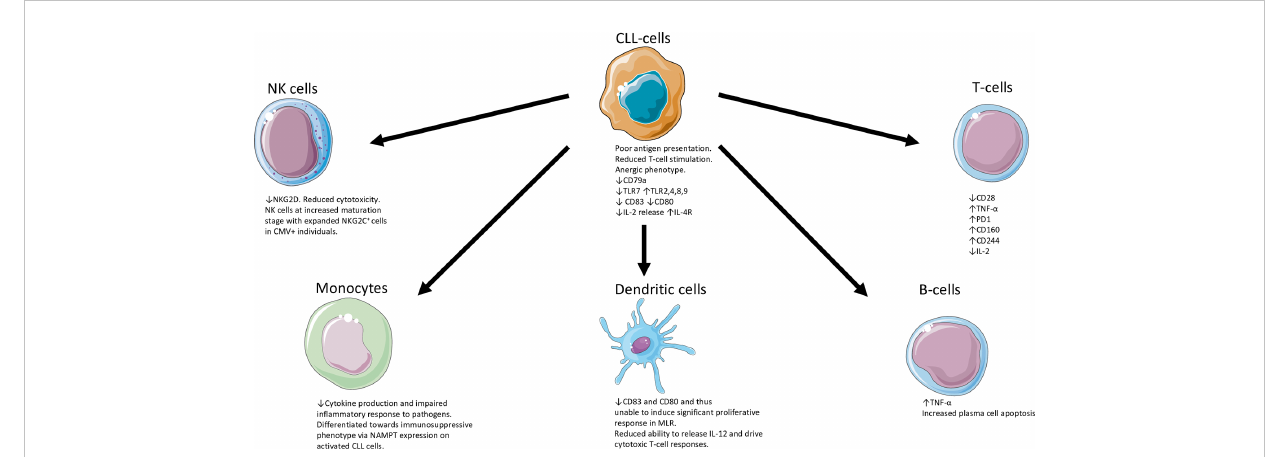
FIGURE 1 Overview of the disruption and chaos of the immune system in patients with CLL (5, 15 – 29). CLL, chronic lymphocytic leukaemia; IL-2, interleukin 2; IL-4R, interleukin-4 receptor; NK, natural killer; TLR, Toll-like receptor; MLR, mixed lymphocyte reaction; NAMPT, nicotinamide phosphoribosyltransferase; PD1, Programmed death protein 1; TNF, Tumour necrosis factor; TLR, Toll receptor. The Figure was partly generated using Servier Medical Art, provided by Servier, licensed under a Creative Commons Attribution 3.0 unsupported